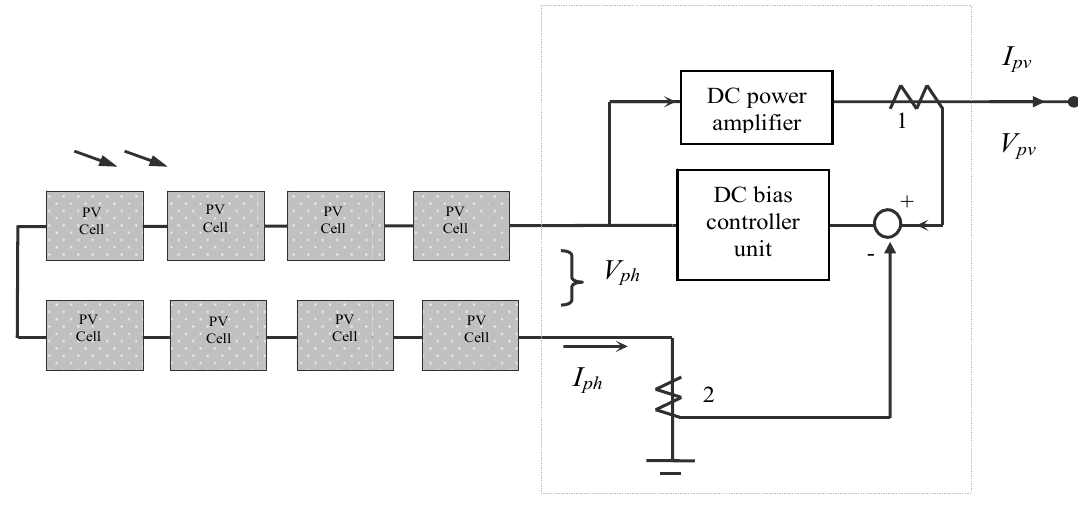
Figure 5. Multiple solar cells based PV simulator.